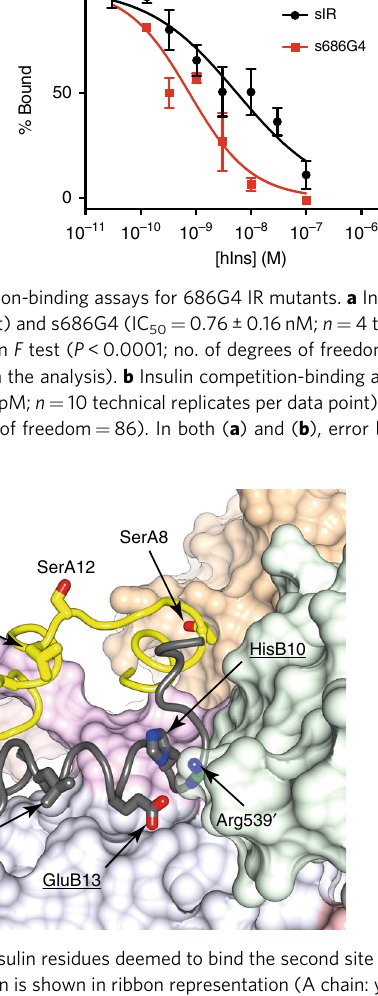
Fast Flow (GE Healthcare Life Sciences) and equilibrated with 1.5M acetic acid, 7M urea, pH adjusted to 3.0 with HCl (buffer A). BOC-modi fi ed bIns pellets were dissolved in 50mL buffer A and after loading onto the column in several portions, variously-BOC-modi fi ed bIns fractions were eluted with gradients of buffer A to buffer B (1.5M acetic acid, 7M urea, 0.5M NaCl, pH adjusted to 3.0 with HCl) as follows. The column was pre-loaded with 0.25 column volumes (CVs) of buffer A followed by injection of 9mL BOC-modi fi ed bIns. The column was then washed with 1 CV of buffer A, followed by gradients of 0 to 10 % buffer B (0.25 CV), 10 to 25% B (4 CV), and 25 to 100% B (0.2 CV). The volume of the peak fractions putatively containing BBI (as opposed to mono- and tris-BOC bIns; putative peak identi fi cation kindly provided by Mr John Bentley (CSIRO; Parkville, Australia) 29 , see below for fi nal mass spectroscopy veri fi cation) was then reduced by pooling and binding again to the column and eluting as follows. Approximately 3L of fractions containing BBI were diluted 1:1v/v with water, loaded in portions on the column and re-eluted with a single gradient of 200mL 0 to 100% buffer B. Approximately 370ml of combined BBI fractions were dialysed in two 40cm long 54mm diameter 3.5kDa cut-off dialysis bags against 10L pure water with more than twenty changes. BBI precipitated by dialysis was collected by centrifugation. Sedimented BBI pellets